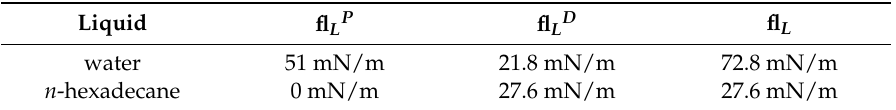
Figure 6. Contact angles of tested liquid on normal and anodized aluminum surfaces. ( a ) Contact angle of water on normal Al; ( b ) Contact angle of n-hexadecane on normal Al; ( c ) Contact angle of water on anodized Al; ( d ) Contact angle of n-hexadecane on anodized Al. Table 3. Parameters of the tested liquid for surface energy measurement.